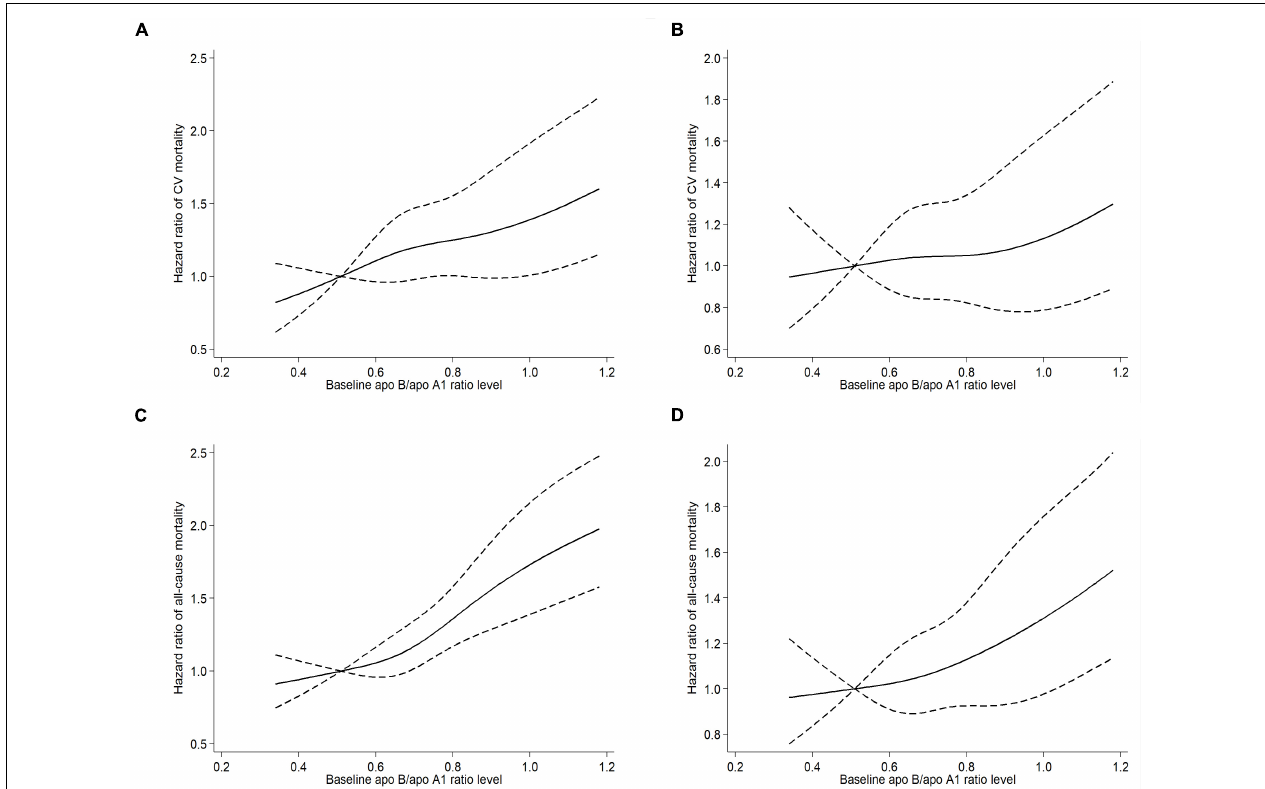
FIGURE 3 | Univariable (A) and multivariable (B) adjusted hazard ratios of CV mortality, univariable (C) and multivariable (D) adjusted hazard ratios of all-cause mortality associated with apo B/apo A1 ratio levels in Cox model using restricted cubic splines, adjusted for age, sex, diabetes, a history of CV events, body mass index, systolic blood pressure, hemoglobin, serum albumin, hypersensitive C-reactive protein, estimated glomerular filtration rate, total Kt/V, and statin use. Apo A1, apolipoprotein A1; Apo B, apolipoprotein B; CV, cardiovascular.